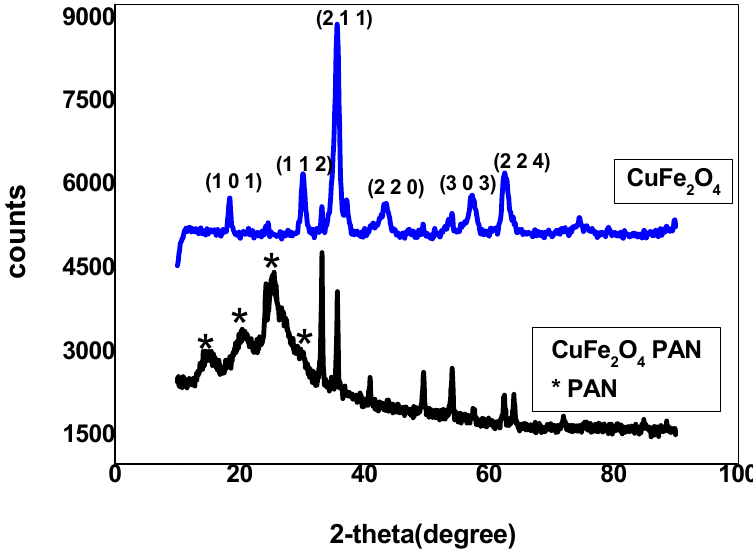
Figure 1. Pattern of both CuFe 2 O 4 and CuFe 2 O 4 /PANI nano-composites.